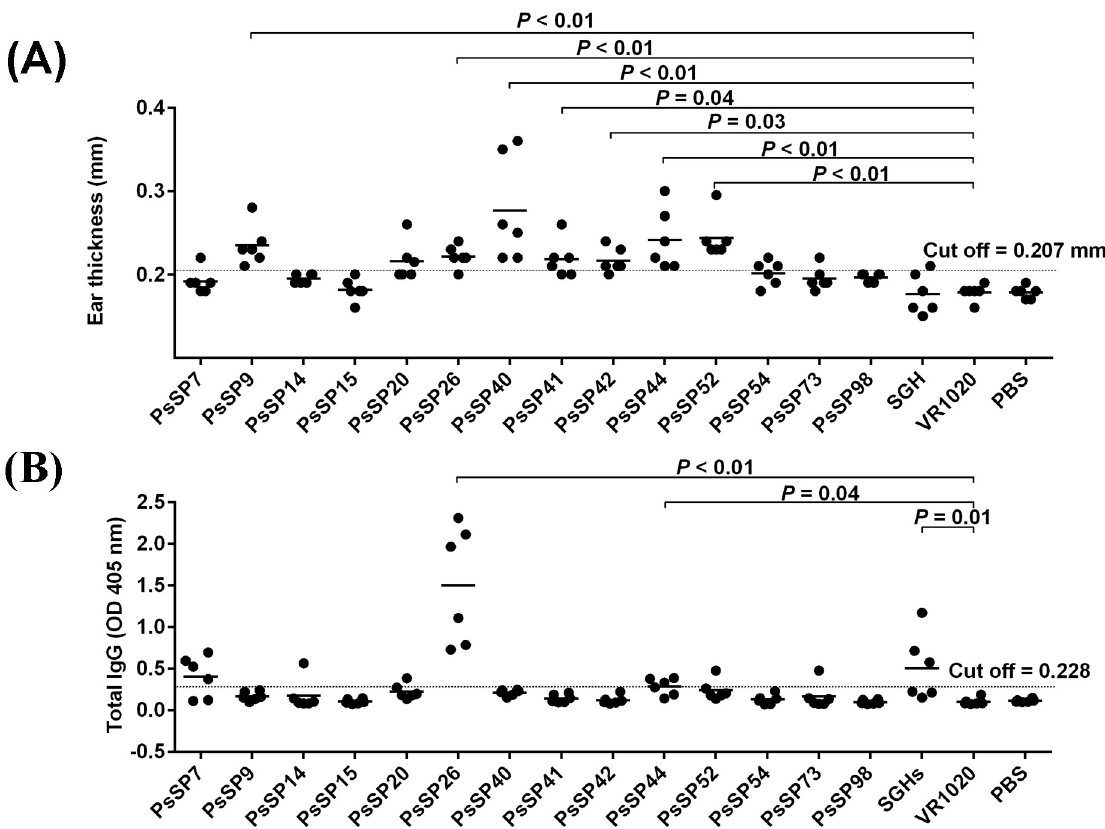
Fig 2. DTH and antibody responses to Ph . sergenti salivary proteins. BALB/c mice (six mice per group) were immunized in the right ear three times at two week intervals with plasmids encoding for fourteen Ph . sergenti salivary proteins (10 μ g), Ph . sergenti salivary gland homogenate (SGH, 0.5 pair), empty plasmid (VR1020, 10 μ g) or PBS (control) in total volume of 10 μ l with PBS. Two weeks after the last immunization, the contralateral ear was intradermal challenged with 0.5 pairs of Ph . sergenti SGH. Data shown are from one representative of two independent experiments. (A) Delayed-type hypersensitivity response (DTH) generated at 48 h after Ph . sergenti SGH inoculation was determined. (B) Total IgG antibody response to Ph . sergenti SGH was determined by ELISA in immunized BALB/c. Statistical significance of the difference compared to the control empty-plasmid group (VR1020) is shown for each of the immunized groups. Dashed line, the cut off value determined as the mean + 3 SD of the response of the empty-plasmid control